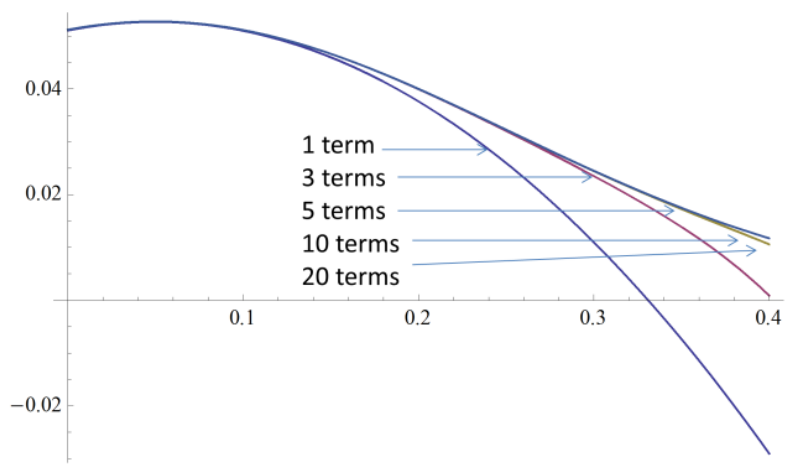
Figure 3. Plots of Equation (7) with increasing numbers of terms, indicated on the plot. The series converges rapidly, indicating that only the first 5 or 10 terms are required for numerical evaluation.